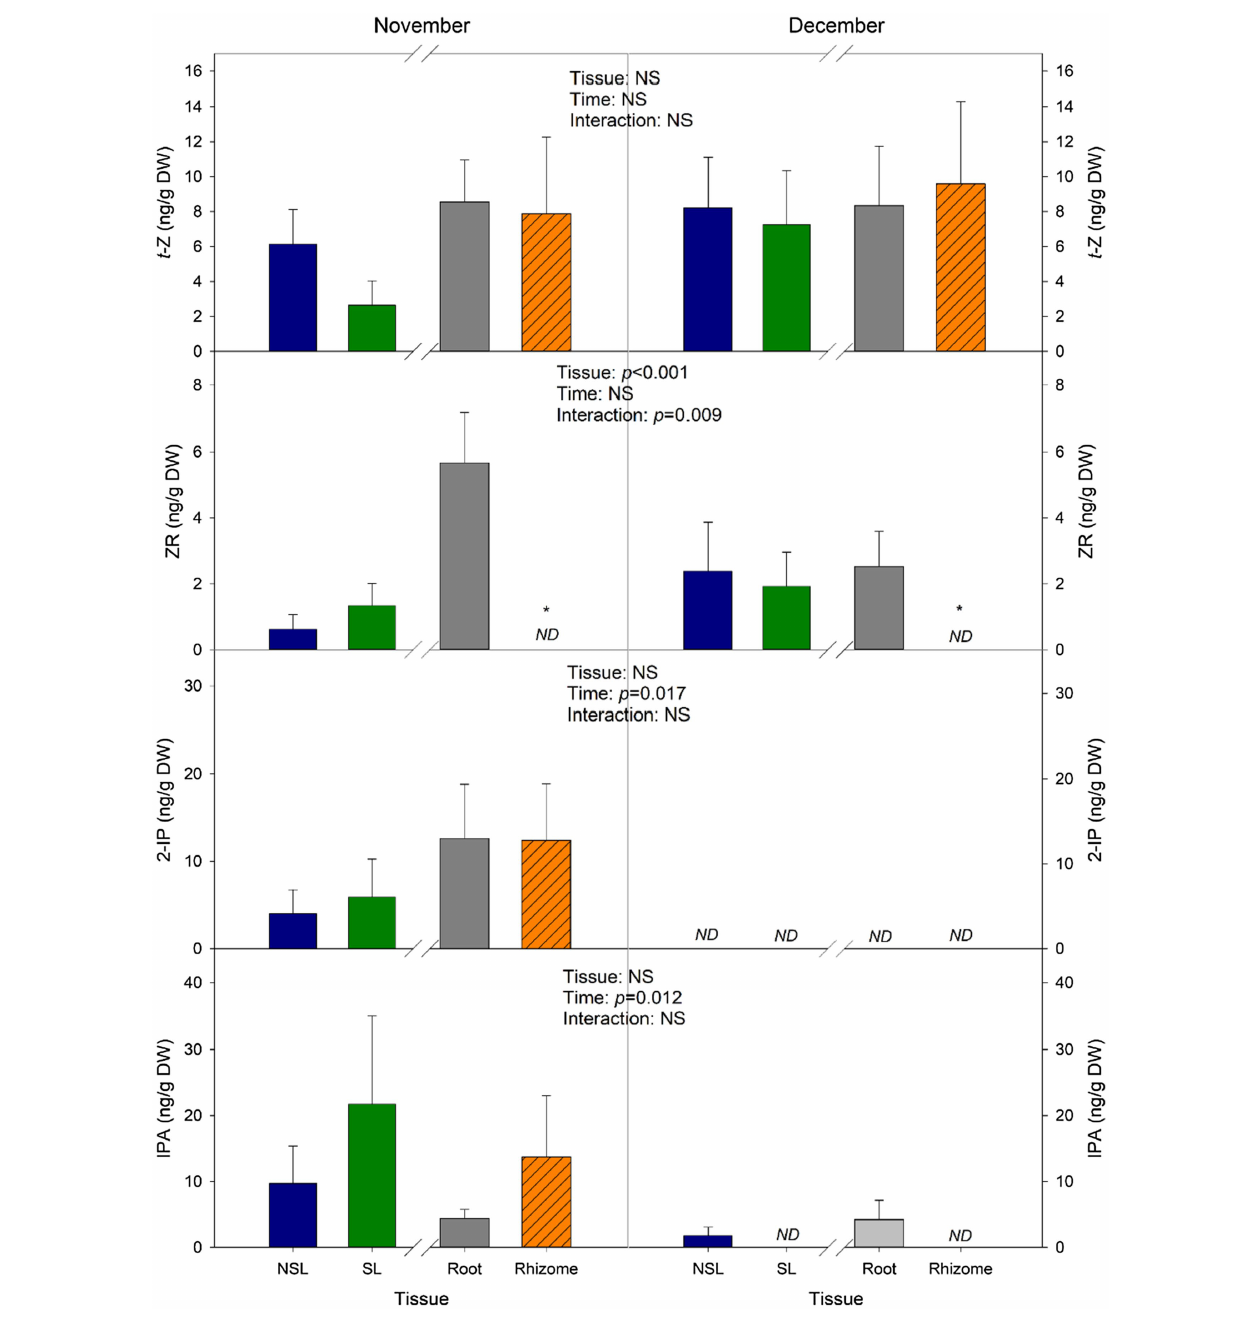
FIGURE 5 | Changes in the concentration of individual cytokinins. Measurements were performed in leaves and subterranean organs of I. pseudacorus . Values of p from the two-way mixed factorial analysis are shown, including the factor Time , Leaf type/Tissue , and their interaction. An asterisk indicates differences between leaf types or root tissue types. Data show the mean ± SE of n = 12 individuals. NSL, non-senescent leaf; SL, senescent leaf; 2-iP, isopentenyladenine; iPA, isopentenyladenosine; t -Z, trans -zeatin; and ZR, zeatin